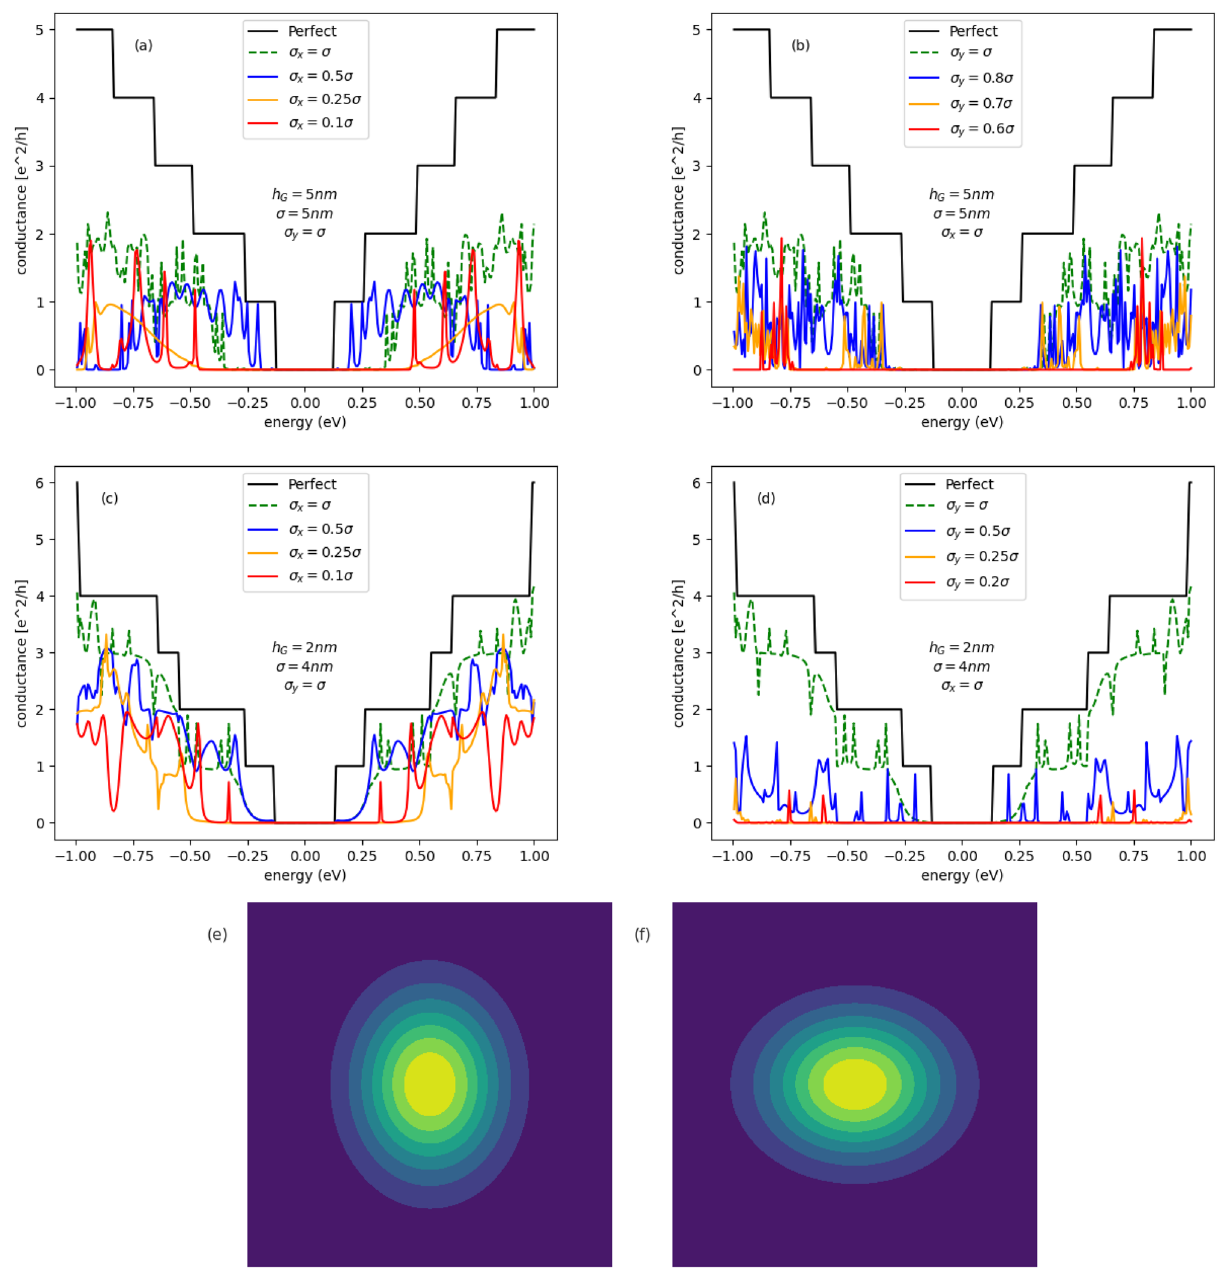
Figure 7. Conductance spectra of semiconducting armchair GNR with the central scattering region in form 39, N 300 ); ( c,d ): ( M 37, N 300 ), for several configurations of elliptic of deformed GQD: ( a,b ) ( M = = = = Gaussian deformation. Conductance spectra given in parts ( a,c ) (left panel) and ( b,d ) (right panel) correspond to the kind of deformation sketched in part ( e,f ),